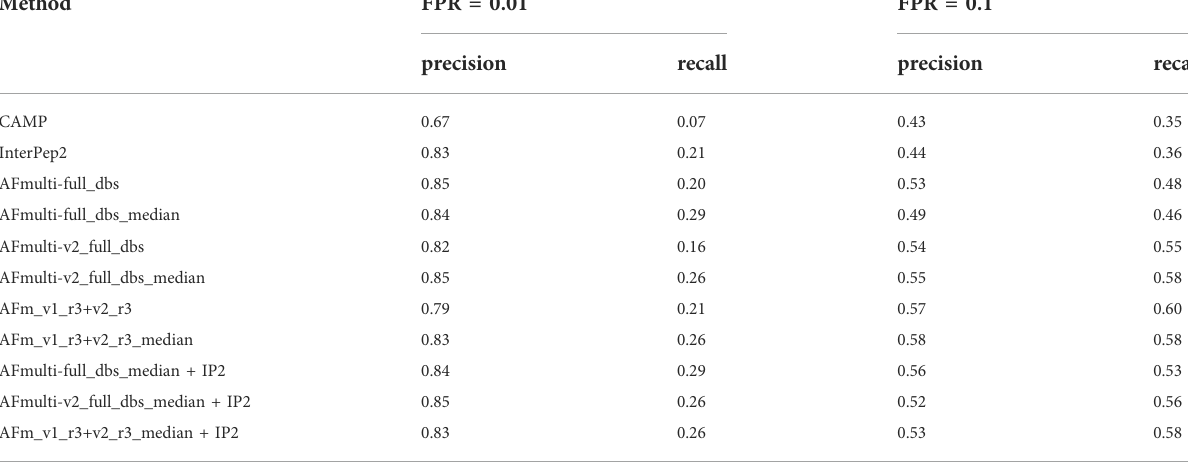
TABLE 3 Summary of interaction prediction results measured by precision, recall at FPR = 0.01, and FPR = 0.1. Method FPR = 0.01 FPR = 0.1 precision recall precision recall